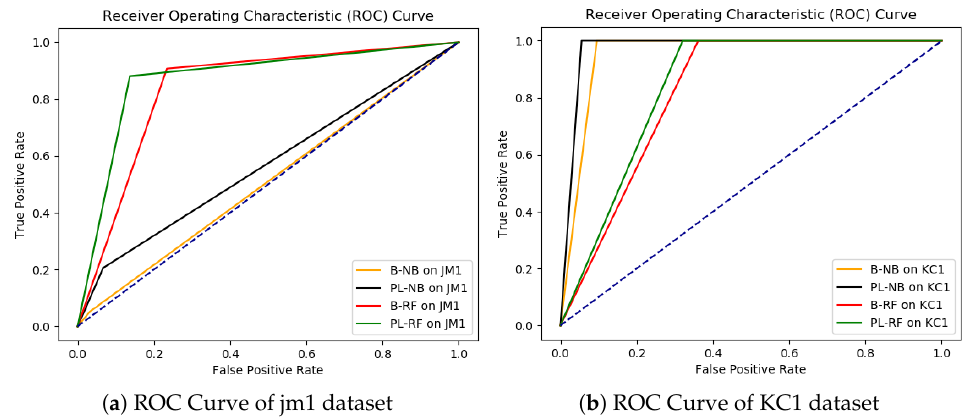
Figure 2. ROC curves of NB and PL-NB, and RF and PL-RF for jm1 and KC1